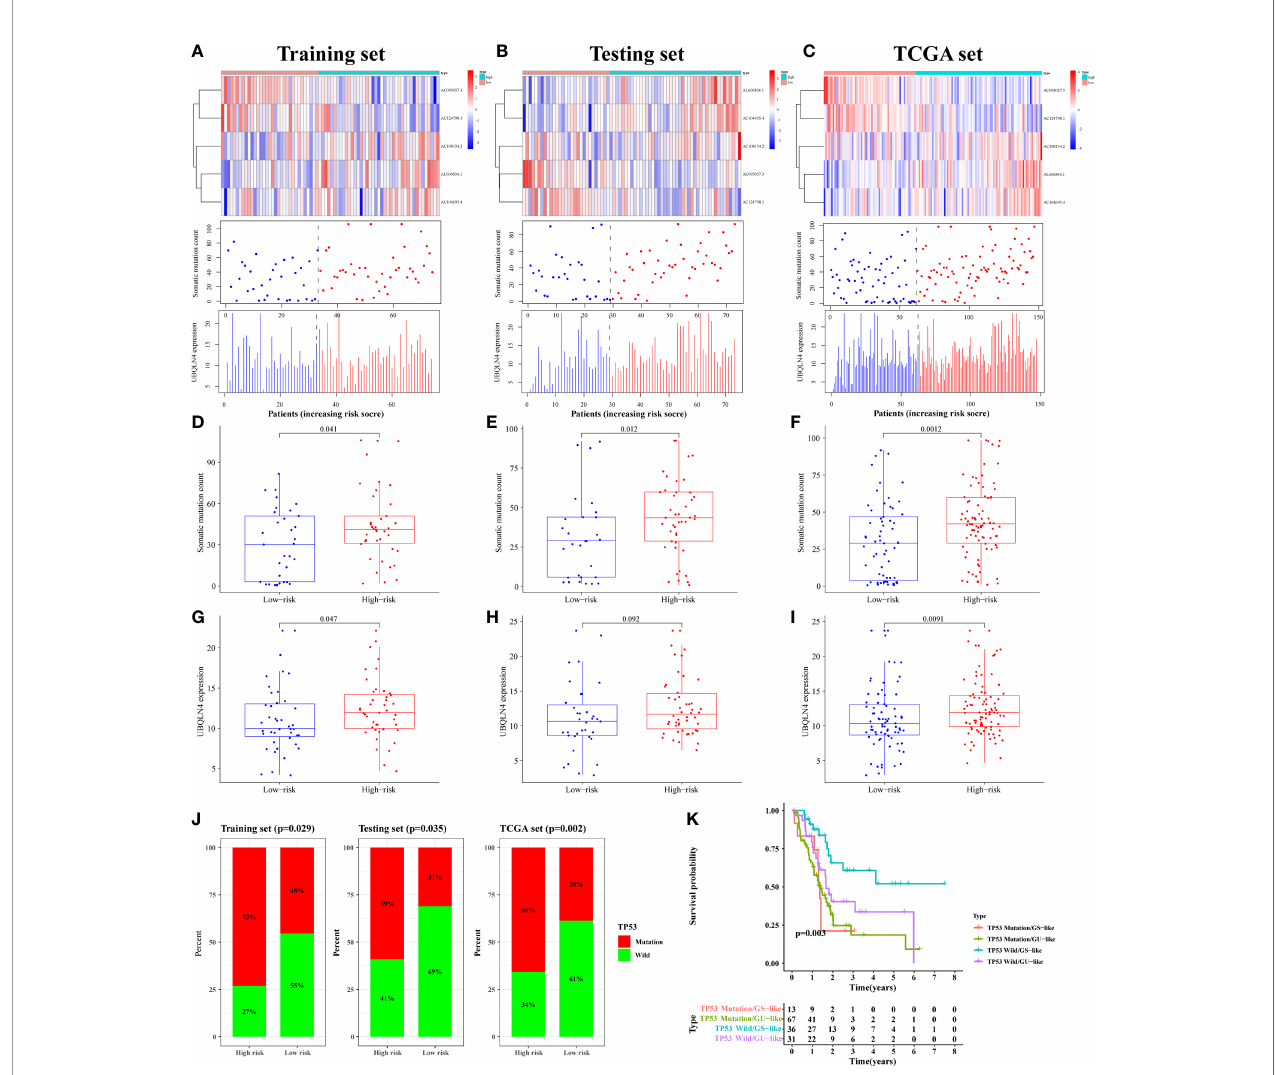
FIGURE 5 | The mutation correlation analysis using for signature veri fi cation. The risk curves of the training (A) , testing (B) and TCGA (C) sets were composed of heat map, gene mutation point map, and UBQLN4 expression map. It re fl ected the changes in the number of gene mutations and the expression levels of UBQLN4 and GILncSig with the increase of risk value. Comparison of somatic mutation count between the high- and low-risk groups in the training (D) , testing (E) and TCGA (F) sets. Comparison of UBQLN4 expression levels between the high- and low-risk groups in the training (G) , testing (H) and TCGA (I) sets. (J) Comparison of the proportion of TP53 mutation status between the high- and low-risk groups in the training, testing and TCGA sets. (K) Combined survival analysis curve graph based on GILncSig clustering and TP53 mutation status.